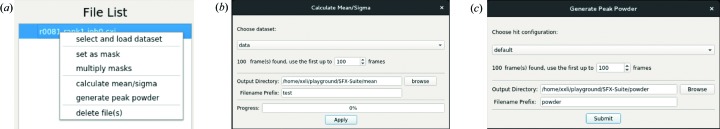
Basic analysis. (a) Right-click file items in the file list panel. Users can perform some basic analyses. (b) Mean/sigma image generation dialog. (c) Peak powder generation dialog.